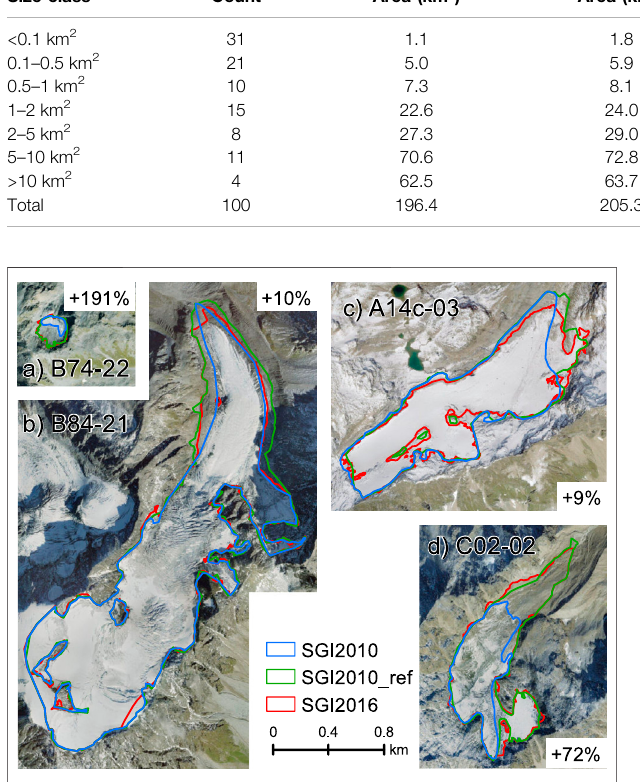
FIGURE 11 | Four examples of re-assessed glacier outlines of the SGI2010 based on the re-digitization experiment using the same source imagery, but with the approaches and de fi nitions used for the SGI2016 ( Supplementary Table S5 ). The re-digitized outlines are labelled SGI2010_ref and area differences relative to the original data set (SGI2010) are given in all panels. (A) Glacier d ’ Orchère (area A 2010 (cid:2) 0.01 km 2 ), (B) Glacier de Valsorey, (A 2010 (cid:2) 1.88 km 2 ), (C) Fanellgletscher (A 2010 (cid:2) 0.83 km 2 ), (D) Bodmergletscher(A 2010 (cid:2) 0.33 km 2 ).Thebackgroundimagery corresponds to the SWISSIMAGE orthophotos used as source data for the compilation of the SGI2010 and the codes represent the unique SGI-IDs.